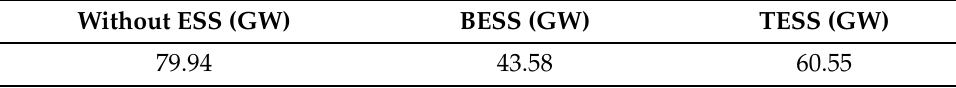
Table 7. Wind power curtailment without and with